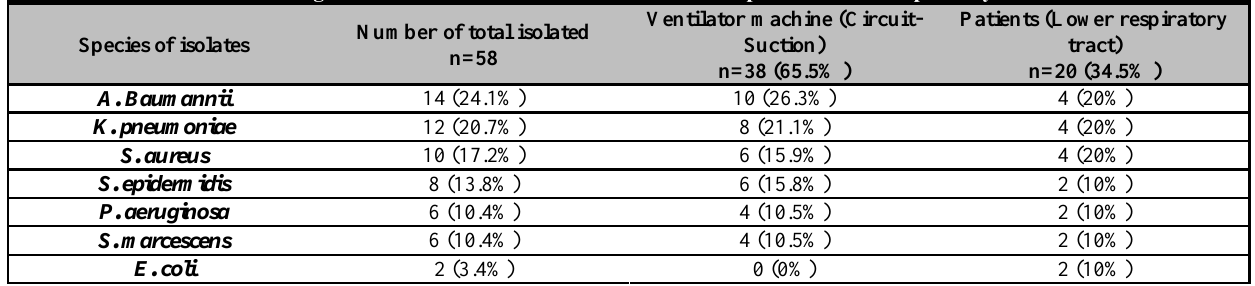
Table 2. Organisms isolated from ventilator circuits and patients’ lowe respiratory tracts Species of isolates